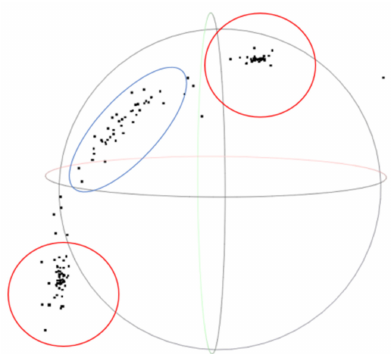
Figure 4. Distribution of triangle normal vectors in three-dimensional space. Normal vectors in the red circles are the centralized distribution, and normal vectors in the blue circle are discrete distribution.